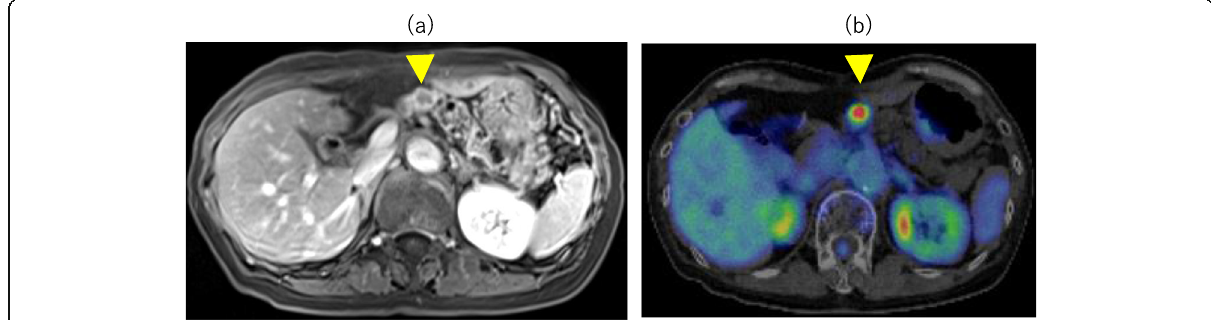
Fig. 4 a Contrast enhanced MRI. revealing a peripherally-contrasted irregular tumor in the remnant pancreas (arrow head). b PET-CT. The maximal standardized uptake value (SUV max) was 6.8 at the tumor (arrow